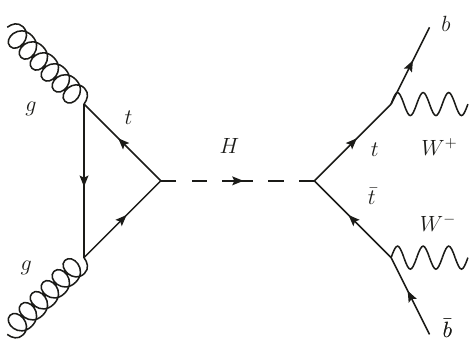
Figure 29 . Feynman diagram for the pp